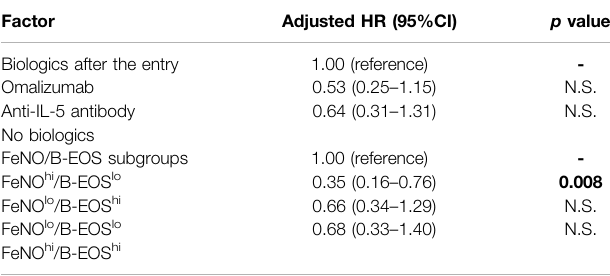
TABLE 4 | Adjusted hazard ratio for the subsequent asthma exacerbation-free time in the FeNO/B-EOS subgroups with biologics use as the confounding